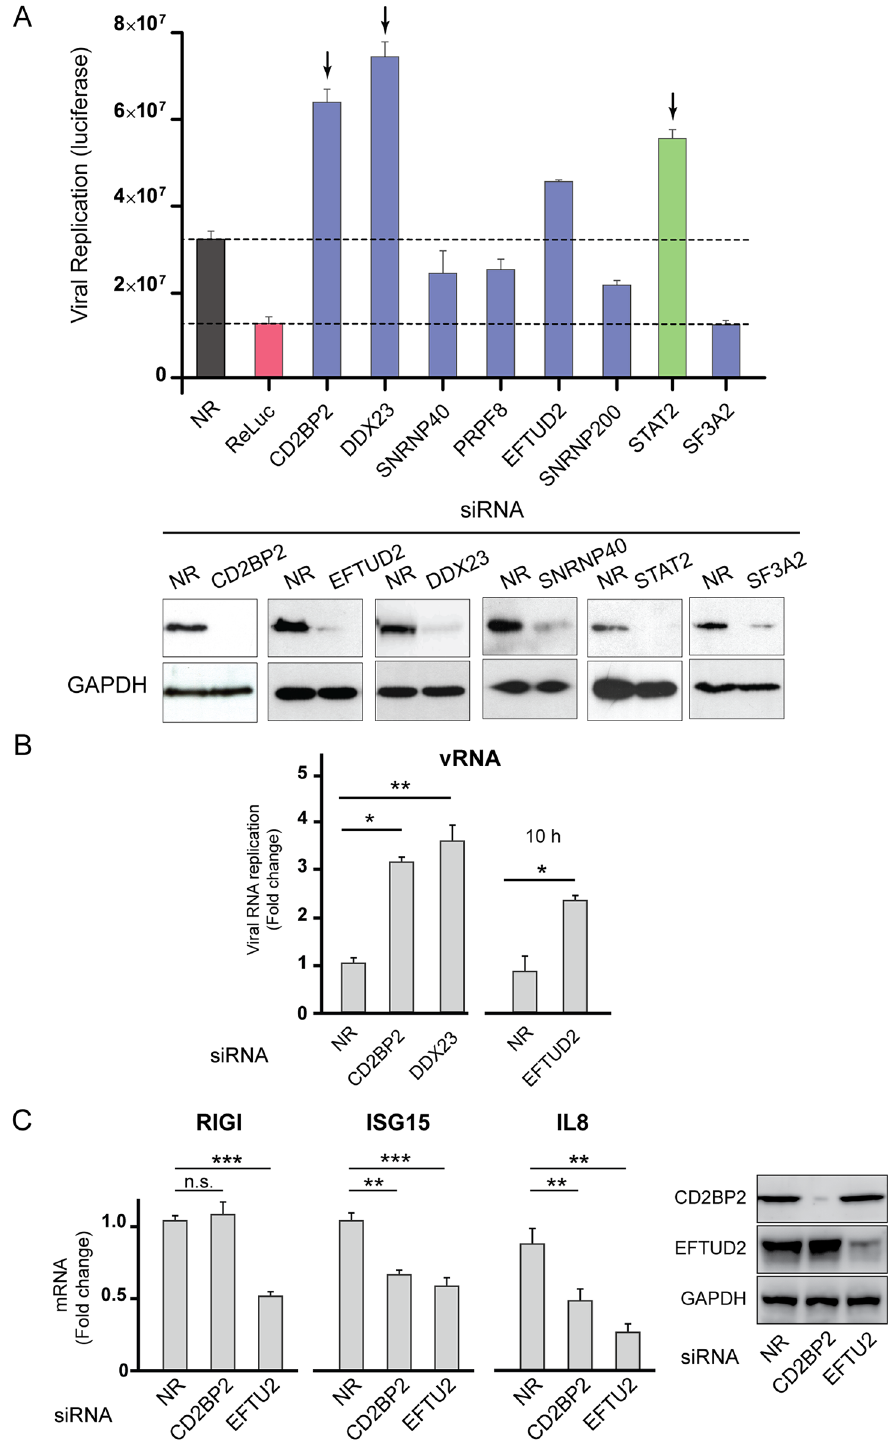
Fig 9. Silencing U5 snRNP components enhances DENV replication. (A) Reporter DENV replication in A549 cells transfected with siRNA directed to spliceosomal proteins (CD2BP2, DDX23, SNRNP40, PRPF8, EFTUD2, SNRNP200 or SF3A2). An infectious DENV carrying the luciferase gene was used. Three controls were included: a non-related siRNA (NR, black bar), siRNAs directed to Renilla luciferase (control for inhibition, red bar) and siRNA directed to STAT2 (control of NS5 binder with antiviral activity, green bar).